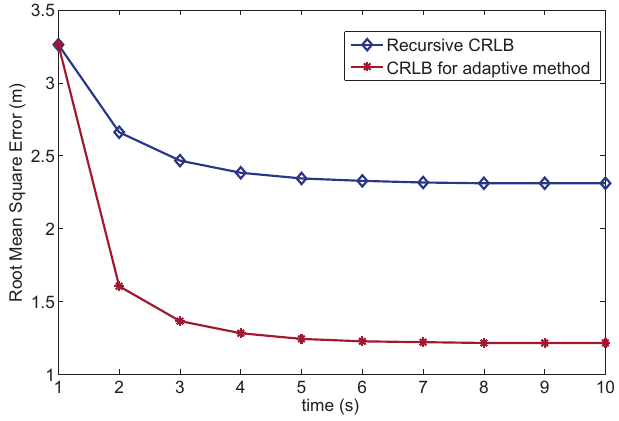
Figure 4. Cramér–Rao lower bound for target tracking.